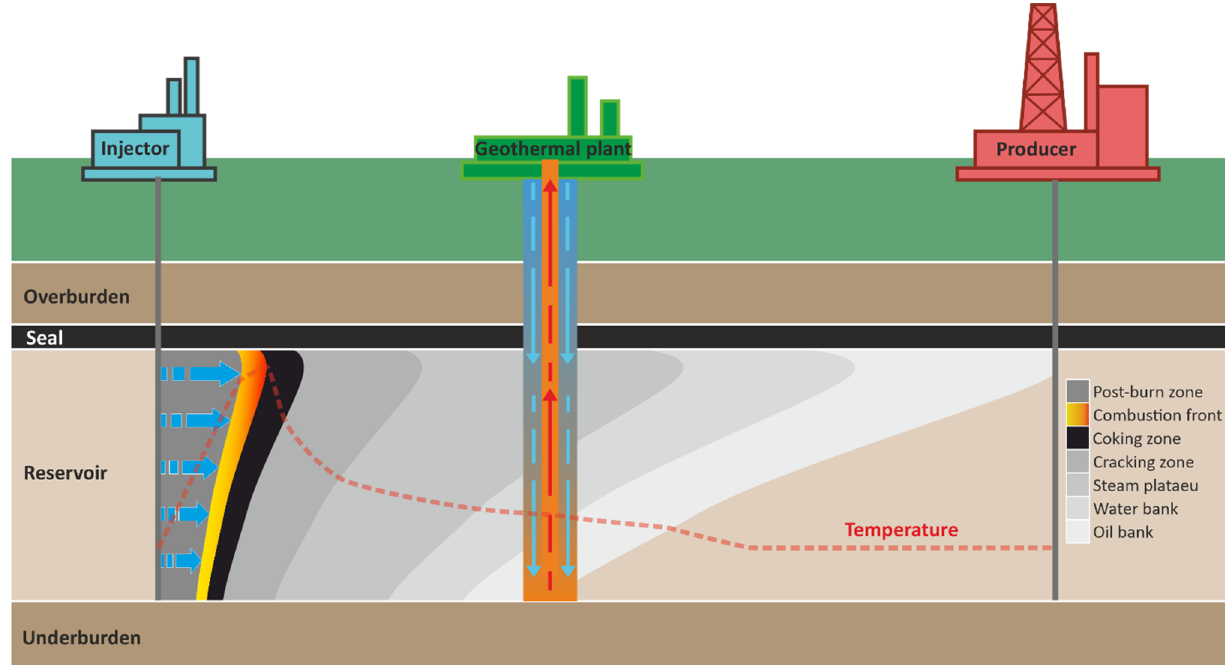
Figure 5. Schematic diagram showing the proposed retrofitting of a heat exchanger between injector and producer to take advantage of the elevated temperatures in the combustion zone during the ISC process, illustrated by the temperature trace superimposed over the ISC zones adapted from [48].